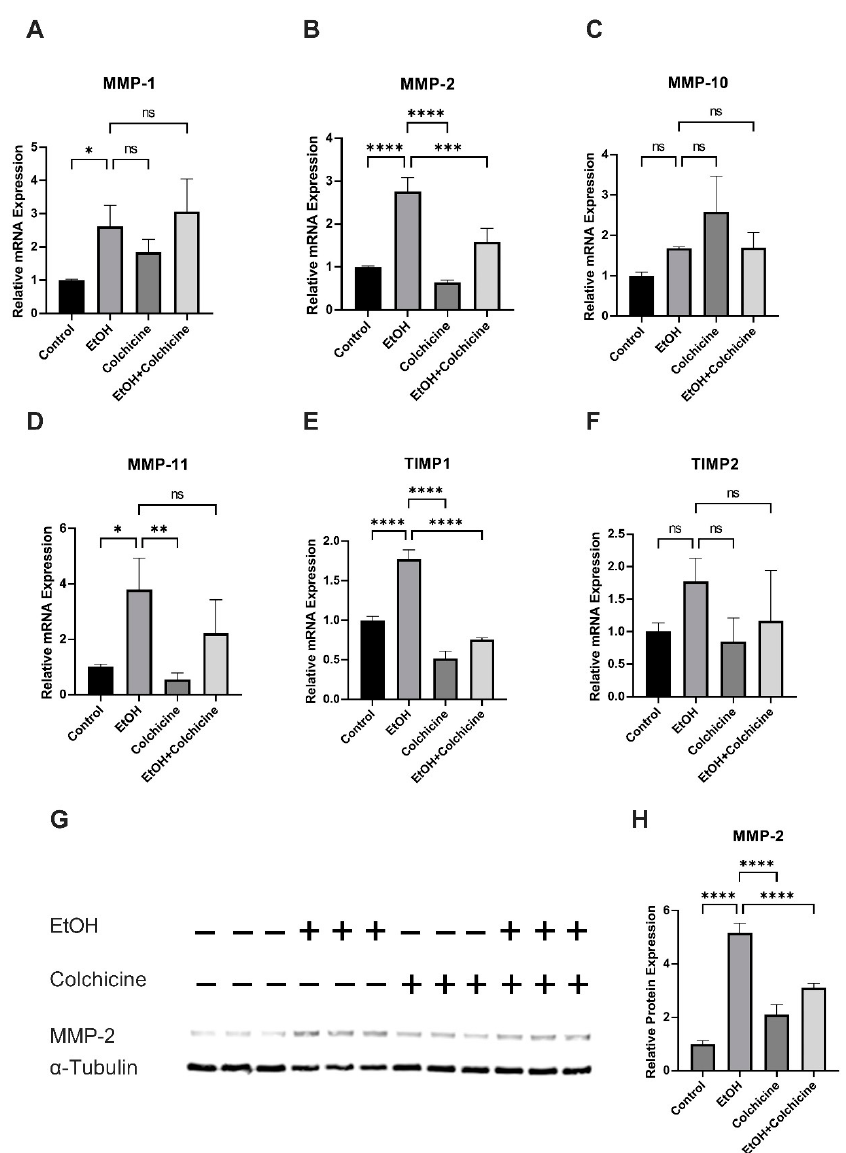
Figure 6. Colchicine abated the relative mRNA and relative protein expression of matrix metallo- proteinase (MMP)2. Colchicine did not ameliorate the relative mRNA expression of ( A ) MMP1 or ( D ) MMP-11. Ethanol and colchicine did not alter the relative mRNA expression of ( C ) MMP-10 or ( F ) tissue inhibitor of metalloproteinase (TIMP)2. Colchicine attenuated relative mRNA expression of ( E ) TIMP1 and ( B ) MMP-2 and relative protein expression of ( G , H ) MMP-2 in ethanol-treated cells. β -actin for qPCR and α -tubulin for WB were used as a loading control. qPCR data are the